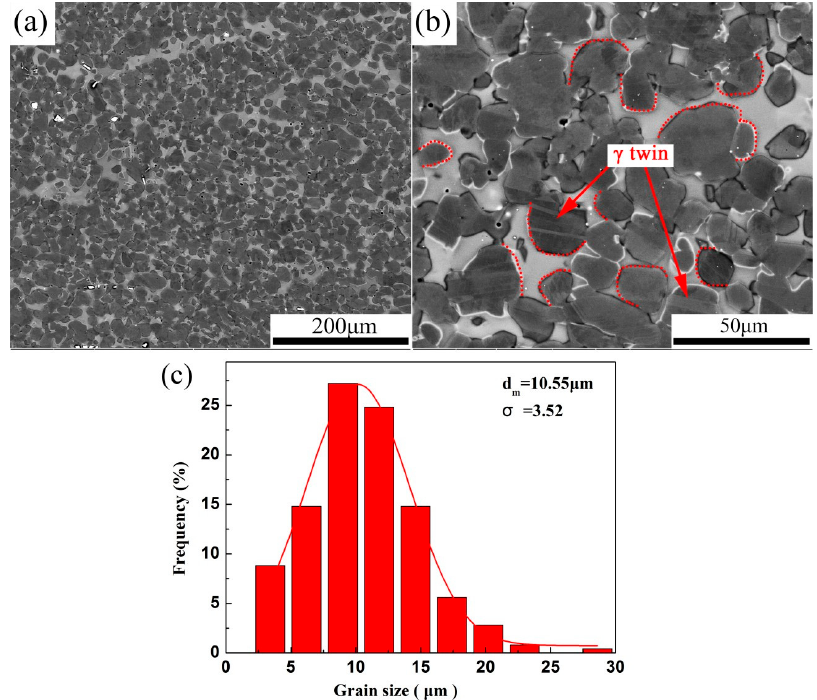
Figure 4. ( a , b ) BSE images of the hot-rolled Ti-43Al-9V-0.2Y alloy; ( c ) Area-weighted γ grain size distributions in the TiAl alloy sheet. distributions in the TiAl alloy